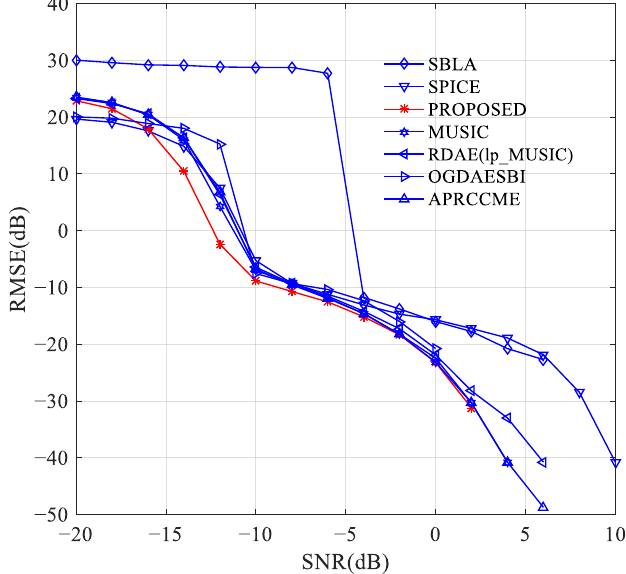
Figure 5. RMSE versus the input SNR.